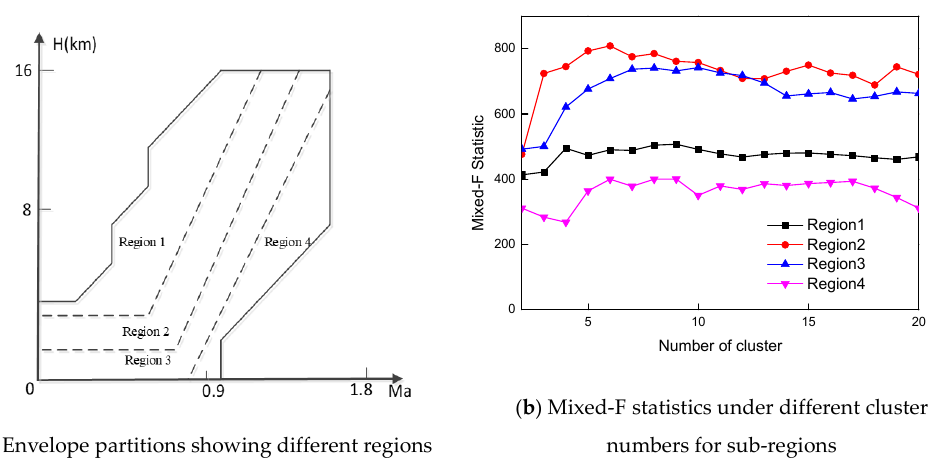
Figure 4. Sub-regions in the flight envelope and the mixed-F statistics in the sub-regions.